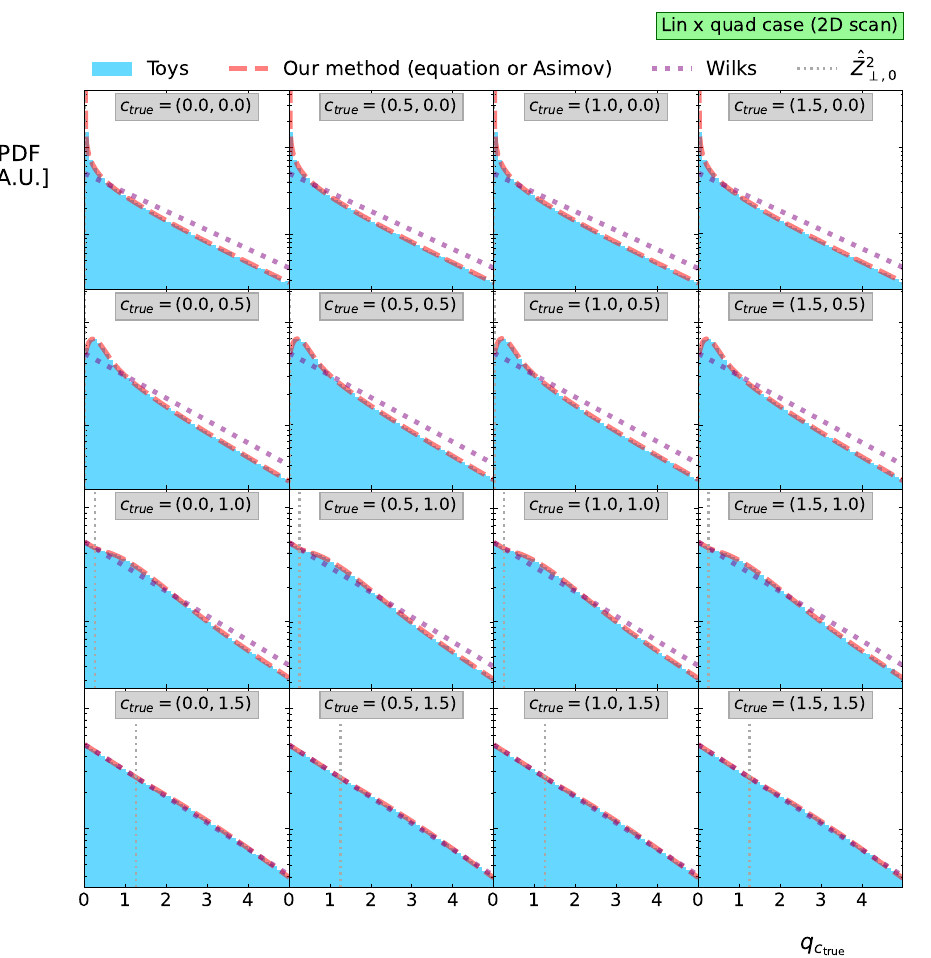
Figure 4: Density of pseudo-experiments compared with our method for a 2D exam- = ( − 0.5,0.3 ) , ¯ n = ( 0.8,0.1 ) and a selection of c ple with ¯ l 1 2 ∼ 0 where Wilks’ theorem is violated. to describe cases with c 2 t,2